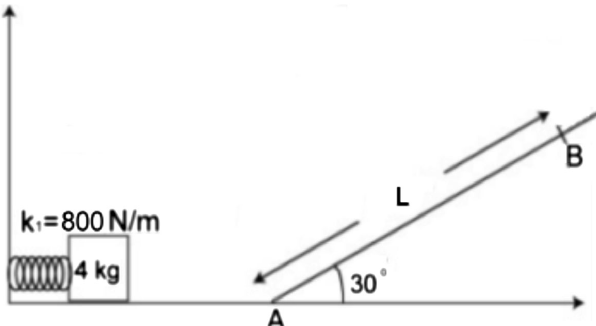
FIG. 7. Figure for paired problem for “ Conservation of energy ”